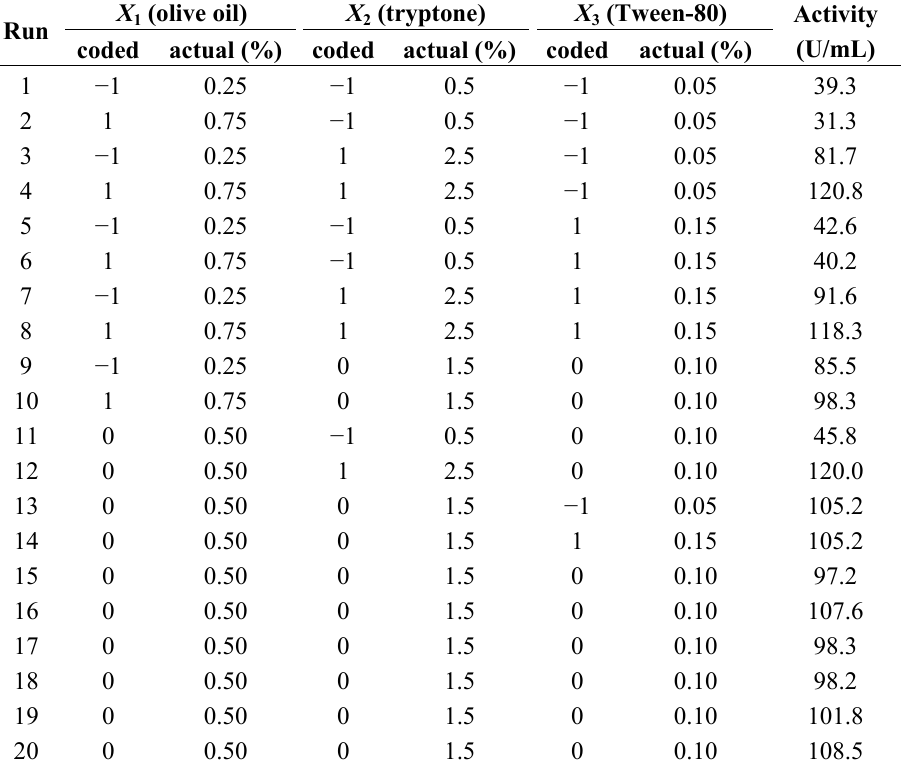
Table 1. Face-centered central composite design of the medium components in coded and actual units for the lipase production.